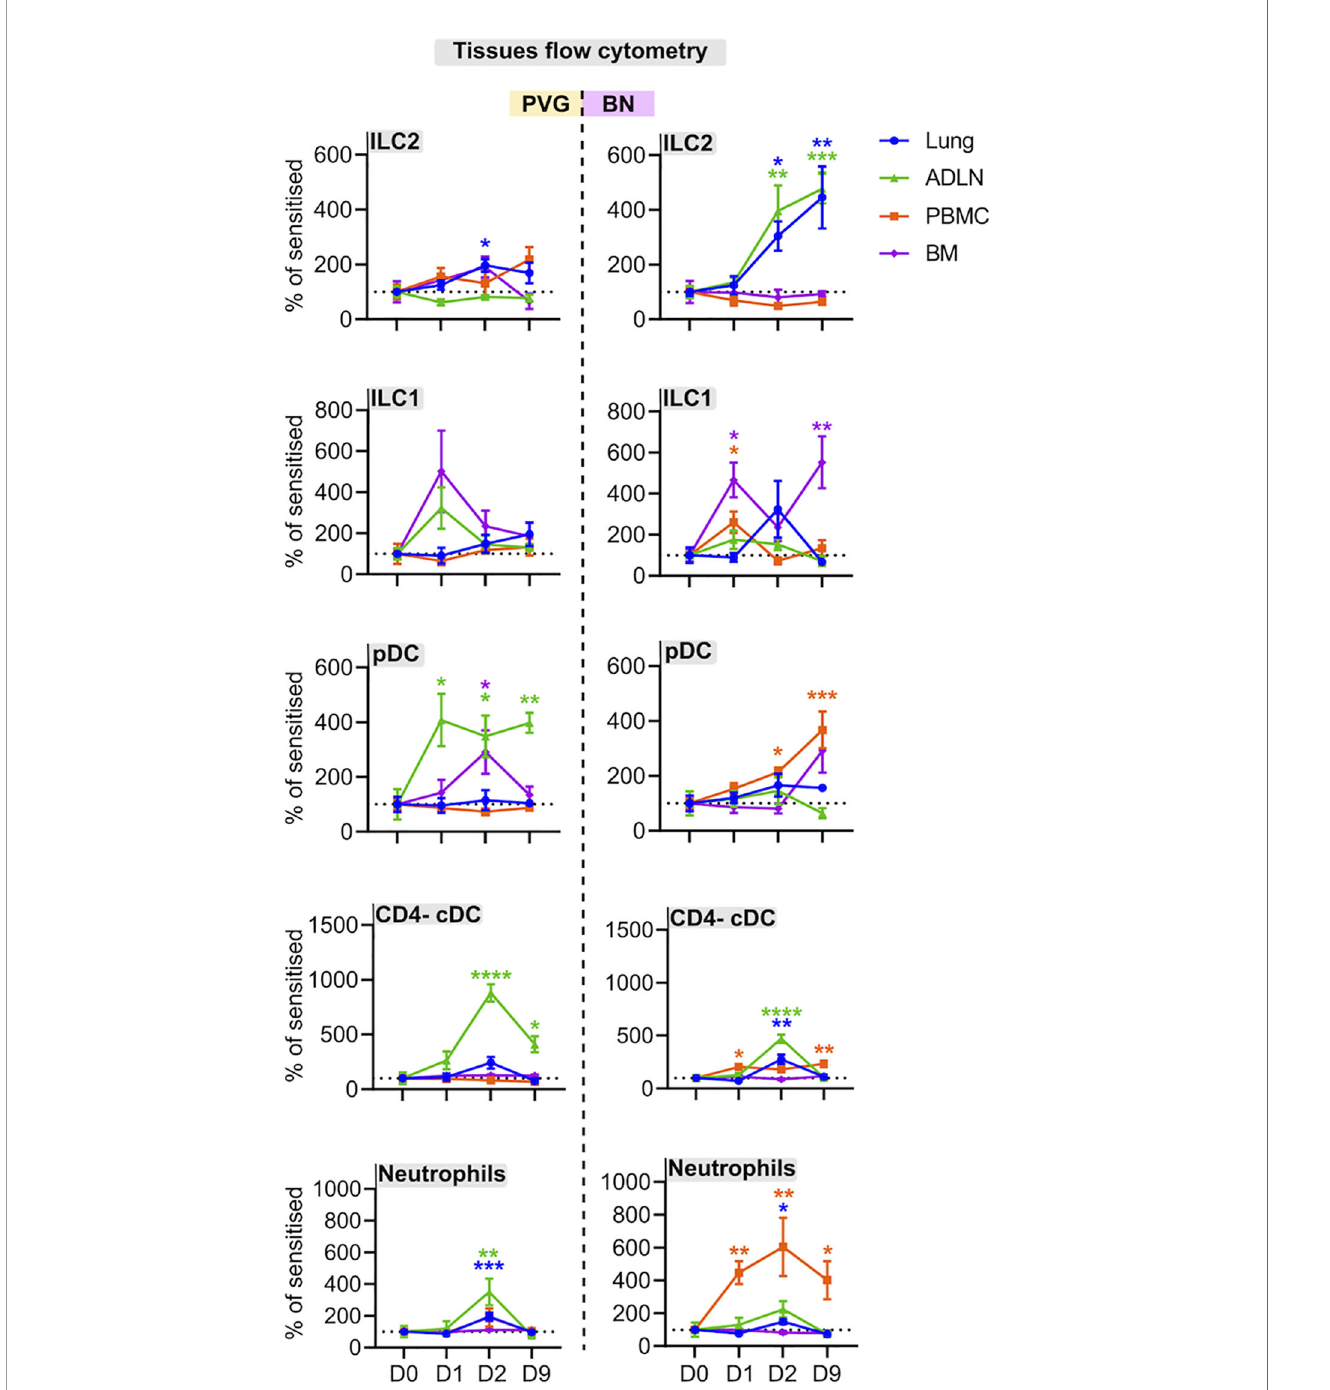
FIGURE 5 | PVG and BN rats display differential cellular recruitment into tissues following challenge with virus and allergen. Flow cytometric analysis of lung, bone marrow, airway draining lymph node (ADLN), and PBMC over the course of viral infection and allergen challenge. Data are presented as the percentage of CD45+ cells (mean ± standard error of the mean) normalized to Day 0, from more than 3 independent experiments with n = 4-6 per strain, tissue, and time point. One-way ANOVA with Dunnett ’ s multiple comparisons test was performed to determine differences at each time point relative to baseline, within PVG and BN separately. *p < 0.05, **p < 0.01, ***p < 0.001, and ****p <